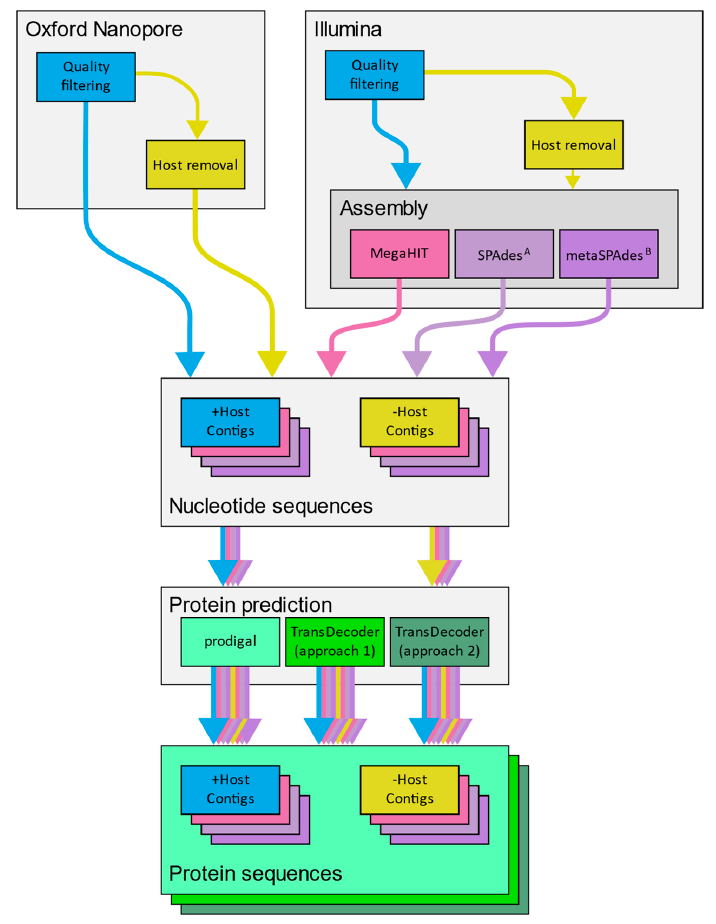
Figure 1. The flow of analysis stages for each simulated library, depending on whether it was produced as an ONT or Illumina dataset. Each set of nucleotide and protein sequences were classified and screened for the virus of interest. Each traversal from raw sequences to a set of nucleotide and protein sequences is referred to as an analysis iteration.